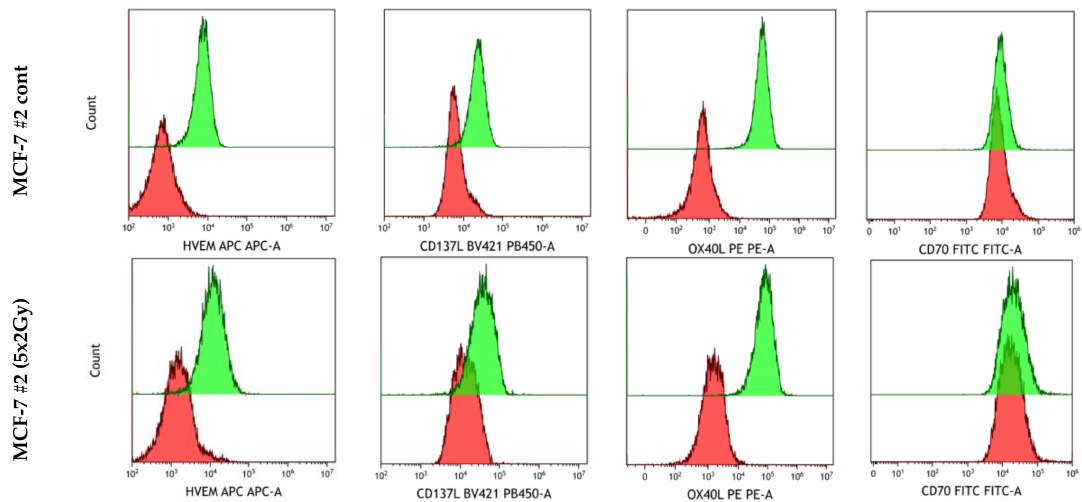
Figure A5. Fluorescence intensity (FI) peak of each fluorochrome of Panel#2 for untreated (cont, d5) and irradiated (5 × 2 Gy, d5) MCF-7